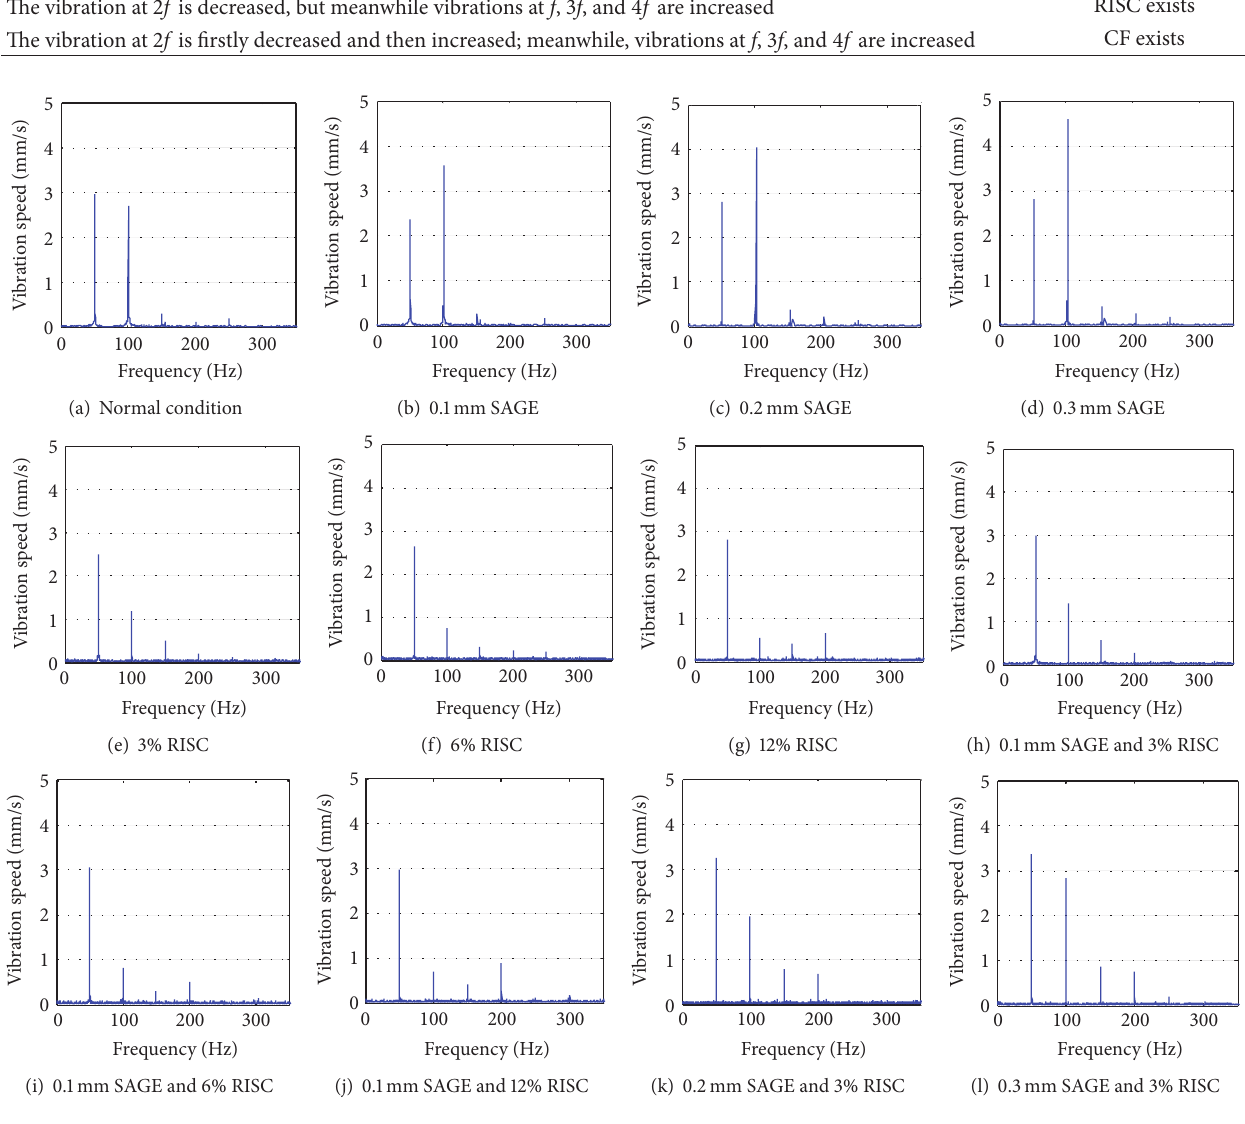
Figure 8: Tested stator vibration spectra under different